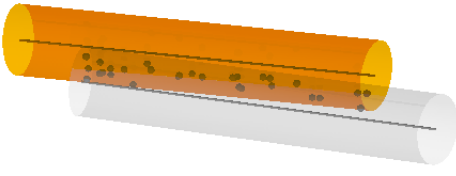
Figure 2: Estimating the cylinder intersection ratio. ments along equally spaced points on s 1 (see Fig.3). The result- ing descriptor is a concatenation of P D ( s 1 , s 2 ) and P D ( s 2 , s 1 ) . To make our descriptor symmetric, we set the order of concate- nation based on which segment in the pair has the starting point with the smallest x, y and z coordinate (tie breaking in this order).